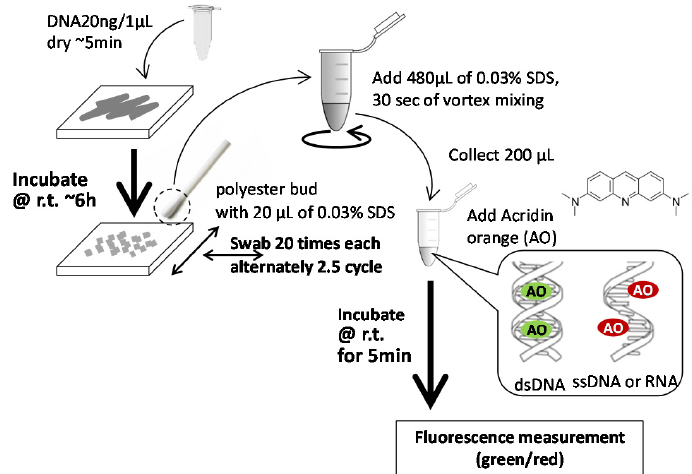
Figure 10. Schematic explanation of the procedure for the evaluation of the nucleic acid degradability of material surfaces by a swab method.